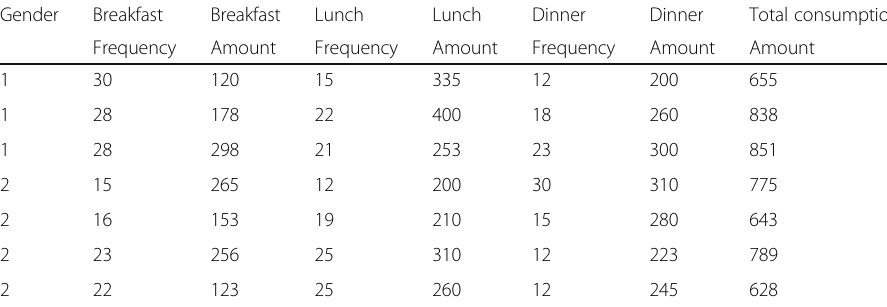
Table 1 Data format before dimension